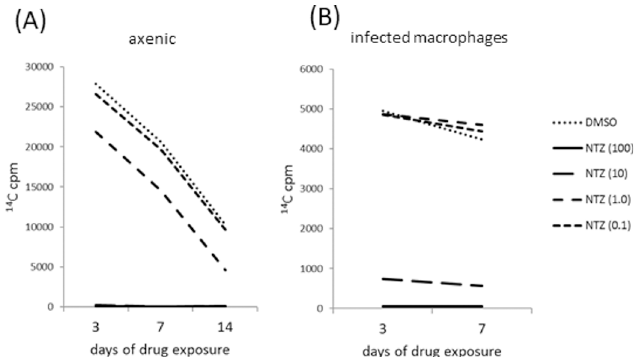
Fig 1. Metabolic activity of M . leprae treated with RIF and NTZ. M . leprae were cultured either (A) axenicallyor (B) followinginfectionof macrophages. Metabolicactivity of M . leprae was measuredusing radiorespirometry during3–14 days of exposureto 2 μ g /mL RIF or 0.1–100 μ g/mL NTZ. Untreatedcontrol containedDMSO only. Results are representativeof four experiments.